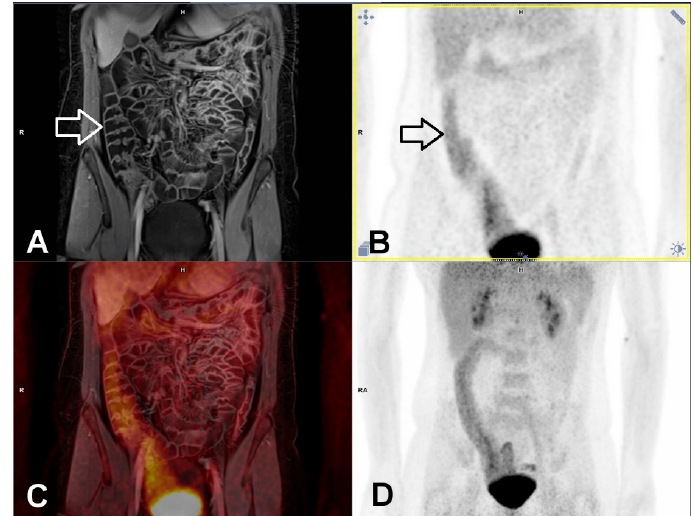
Figure 2. False-positive PET finding in ascending colon in a 29-year-old female patient with previous bowel purgation. Intensive tracer uptake (above liver level) could be clearly demonstrated in ascending colon and adjacent terminal ileum (black arrow in B), though active inflammation was found neither in MR (white arrow in A) nor by colonoscopy. Histology confirmed the absence of neutrophil infiltrate. The combined reading of PET-MR can obviate false-positive interpretation of PET. Notice the good distension of ascending colon following bowel cleansing and oral intake of fluid. ( A ) MR imaging. T1w-3D-VIBE with fat-saturation in the portalvenous phase, ( B ) PET, ( C ) fused imaging of PET and MR, ( D ) maximum intensity projection of PET. Other than CD, in which wall thickness was considered the most important diagnostic